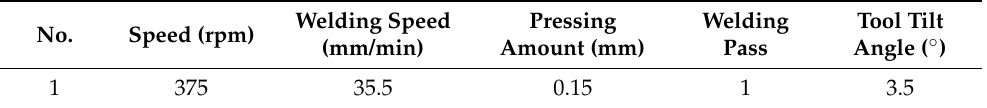
Figure 1. ( a ) Schematic diagram of FSLW; ( b ) Schematic diagram of the size of the stirring pin; ( c ) Schematic diagram of the sampling location of the friction and wear specimen; ( d ) Schematic diagram of the sizes of the friction and wear specimen. Table 2. The parameters of the FSLW process.